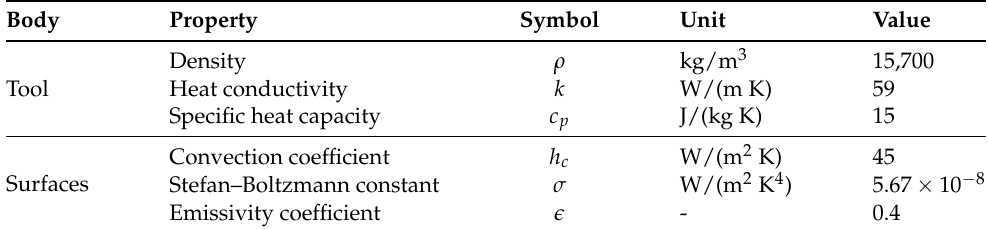
Table 7. Material properties of the carbide cutting tool. Body Property Symbol Unit Value Density ρ kg/m 3 15,700 Tool